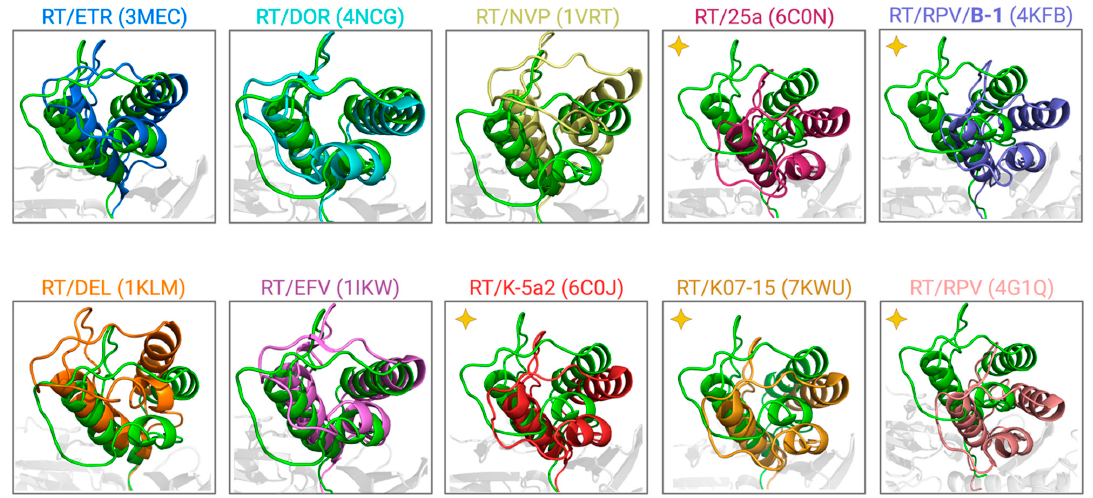
Figure 6. Thumb subdomain position of RT in complex with approved or investigational NNRTIs. The structure of RT bound to 27 (PDB: 8FFX) is superimposed in green in each panel. Stars indicate complexes with measurable NNRTI Adjacent Site pocket volume (Table 4). Definitions: ETR—etravirine; DOR—doravirine; NVP—nevirapine; DEL—delavirdine; EFV—efavirenz; RPV—rilpivirine. Created with PyMOL and